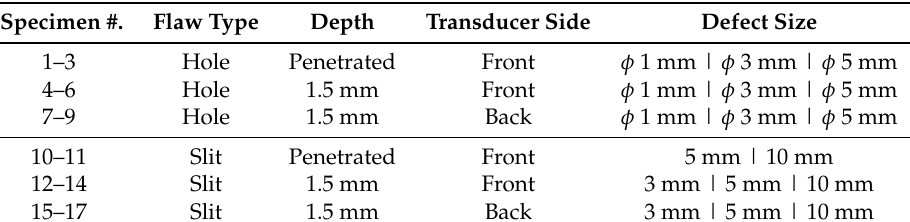
Table 2. Summary of the specimen specifications.